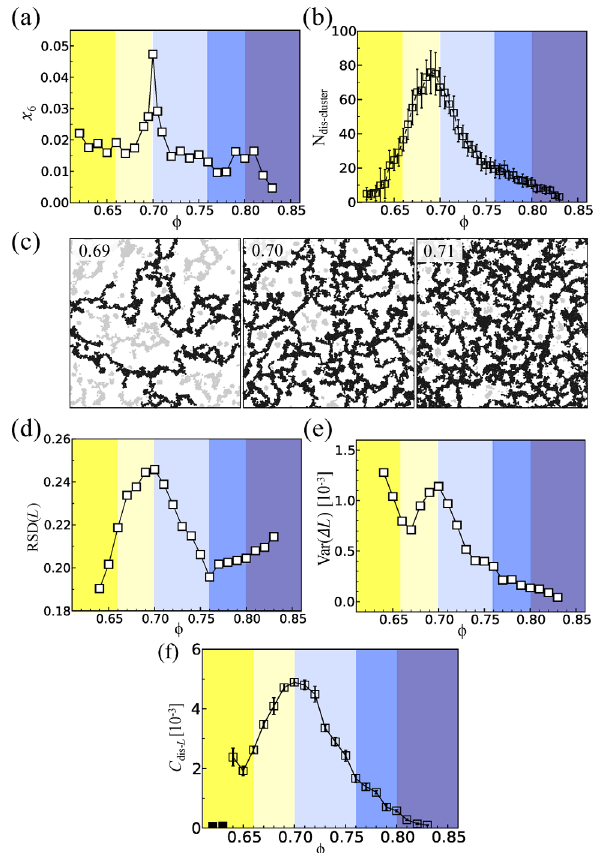
FIG. 2. (a) The structural fluctuation χ 6 . (b) The number of disordered clusters N . (c) Morphologies of disordered dis-cluster clusters. Disordered particles are colored in black for the largest cluster and in gray for other clusters at ϕ ¼ 0 . 69 , 0.70, and 0.71. Black particles percolate at ϕ ≥ 0 . 70 . Crystalline particles are not displayed. Dynamical fluctuations: (d) RSD ð L Þ and (e) Var ð Δ L Þ (see Appendix C). (f) The correlation between dynamics and structural disorder (see Appendix C). The two solid square symbols at ϕ < 0 . 64 correspond to the single crystals whose disorder is nearly 0.